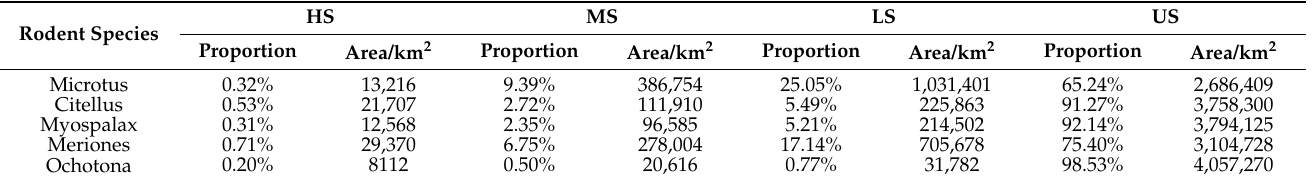
Table 2. The proportions of four environmental suitability categories based on Maxent modeling for five rodent